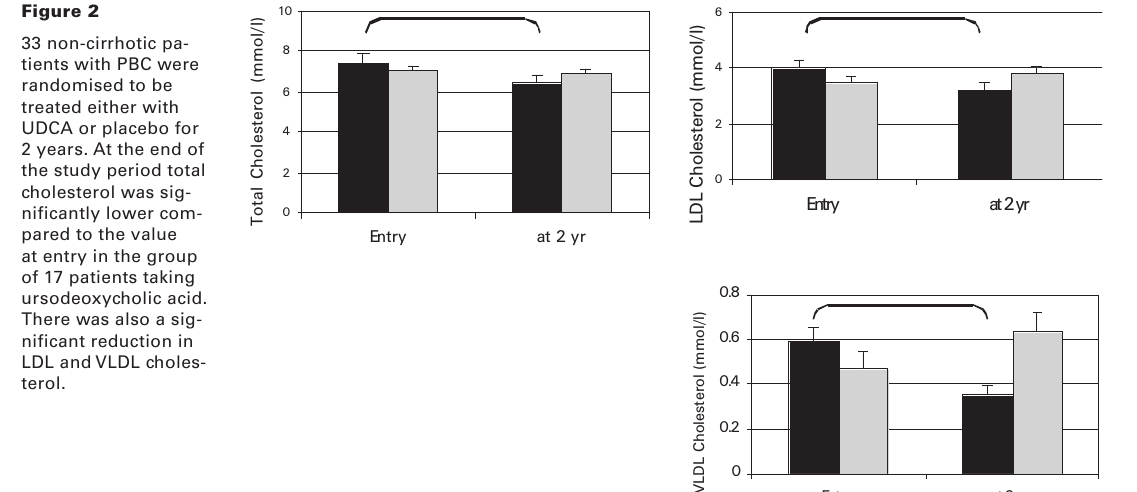
terol level: the higher the basal cholesterol, the greater the effect of ursodeoxycholic acid [7]. Sev- eral mechanisms have been proposed to explain this hypocholesterolaemic effect of UDCA. Obvi- ously, ursodeoxycholic acid improves cholestasis and cholesterol biliary excretion. It reduces the absorption of cholesterol from the gastrointesti-